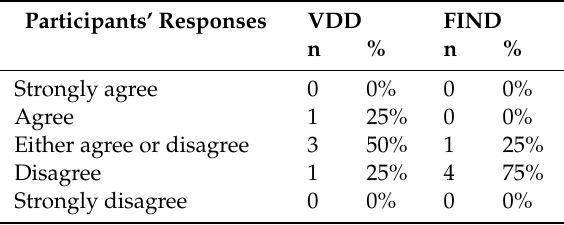
Table 12. Participants’ opinions about the spatial metadata for suitability